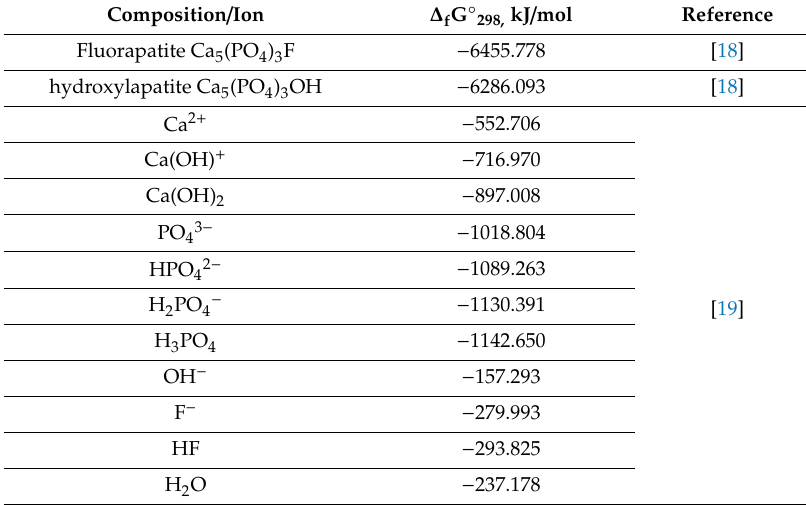
Table 1. Thermodynamic data used for the